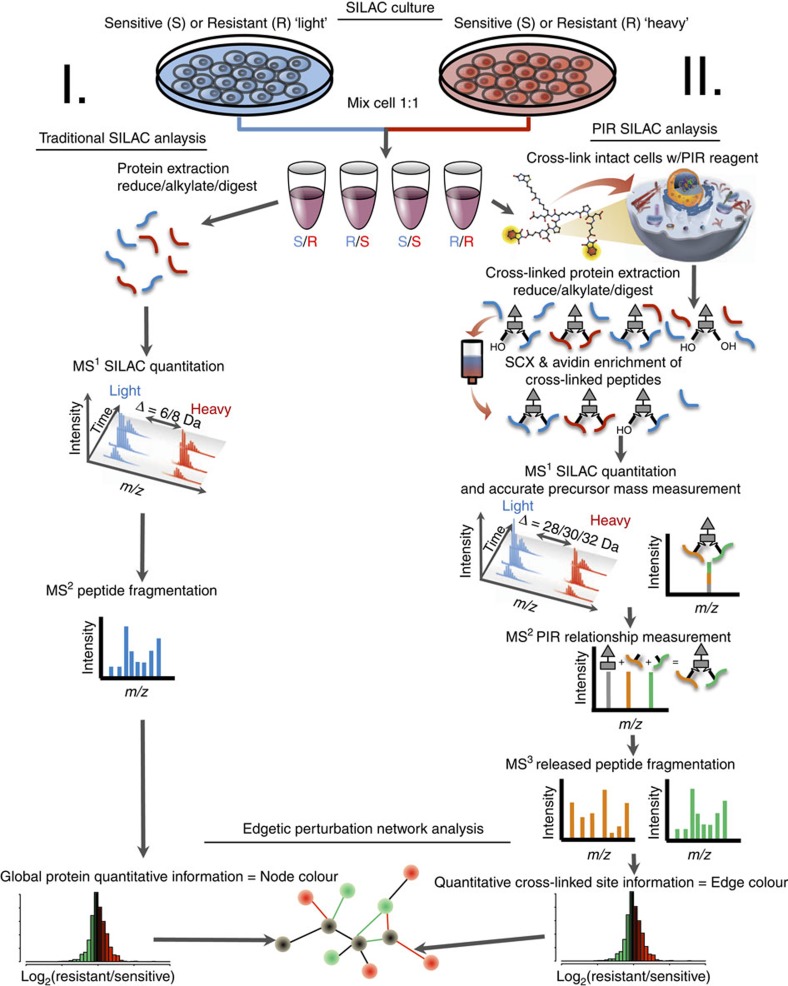
Quantitative in vivo crosslinking experimental flow chart.Drug-sensitive HeLa (S) and drug-resistant HeLa/SN100 (R) cells were cultured in isotopically light and/or heavy stable isotope labeling by amino acids in cell culture (SILAC) media. Light and heavy cells were mixed at 1:1 ratio and either subjected to I. Traditional quantitative SILAC analysis to obtain relative global protein abundances or II. In vivo crosslinking with PIR crosslinker. Crosslinked proteins were extracted reduced, alkylated and digested. Crosslinked peptides were purified by a combination of strong cation exchange (SCX) and avidin affinity chromatography and analysed using ReACT10. Data from the traditional SILAC and crosslinking SILAC experiments were merged into a quantitative interaction network providing an edgotype for multidrug resistance in HeLa cells.